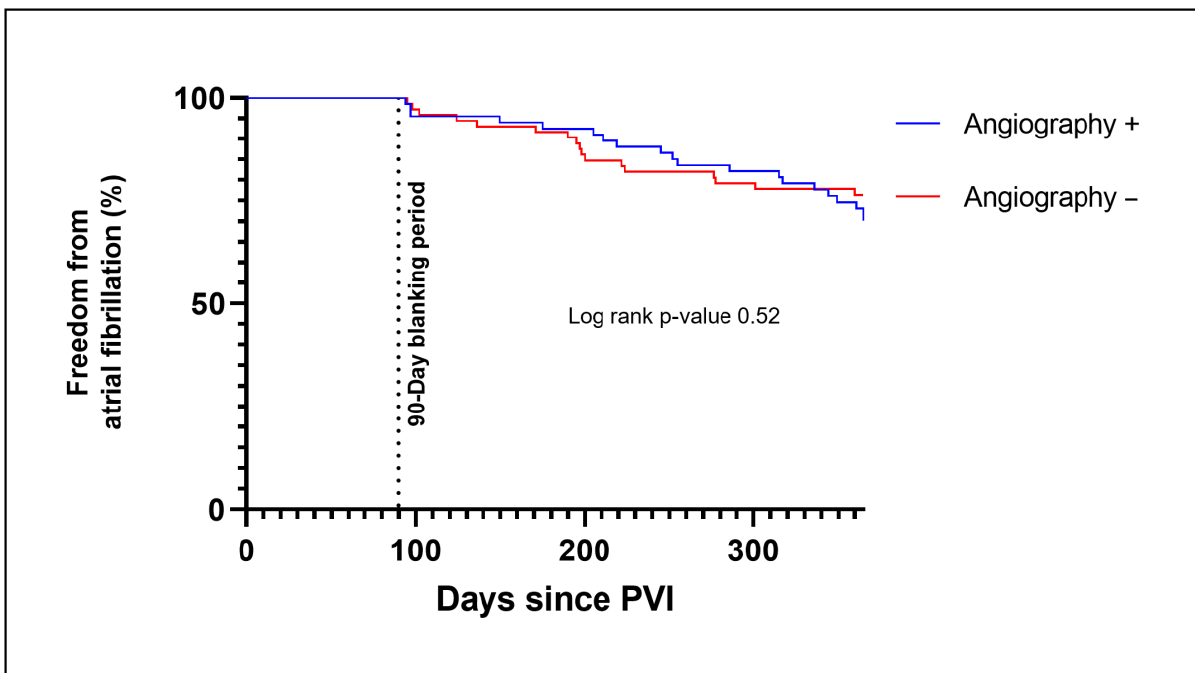
Figure 3. Kaplan – Meier plot for freedom from AF for those patients who received a PV angiography during PVI (Angiography +) and for those without PV angiography (Angiography − ). Recurrences of AF during the 90-day blanking period were not counted in the determination of the first clinical failure. Abbreviations: PVI, pulmonary vein isolation.